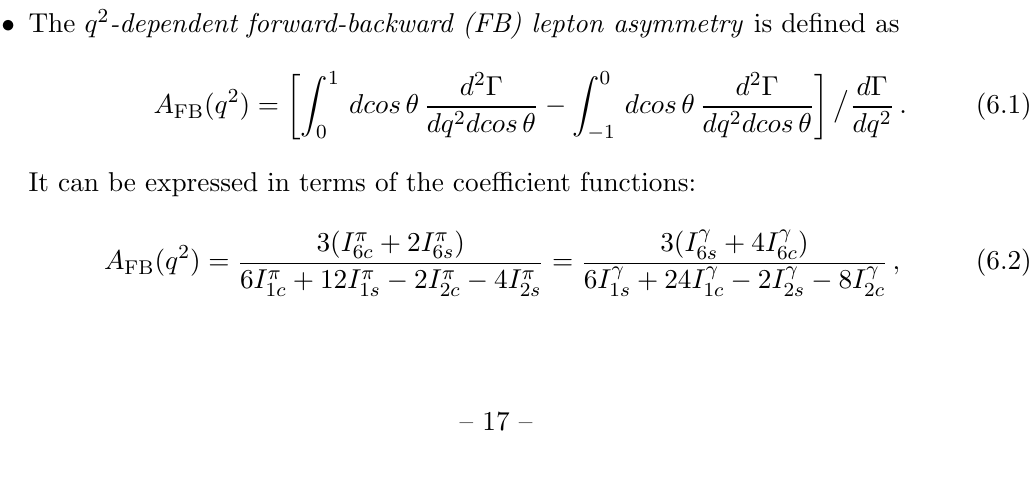
in the low (cid:31) 2 region displayed in T